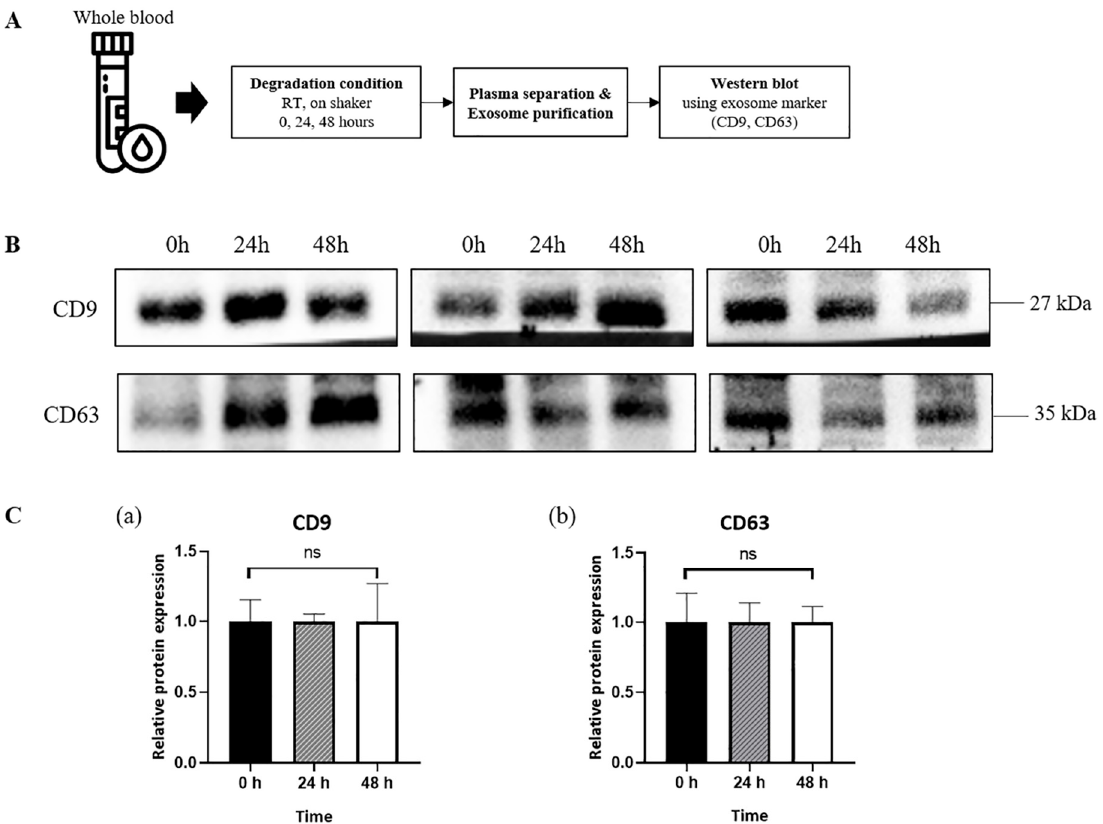
Figure 2. Sustained expression of the exosome surface proteins in the plasma exosomes of the healthy donors. ( A ) A description of the entire experimental process. ( B ) The western blot result of the healthy donors (n = 3) for the exosome surface proteins at 0, 24, and 48 h after isolation. ( C ) The relative protein expression of CD9 ( a ) and CD63 ( b ) were presented as the mean ± standard error of the mean (SEM) of the three experiments. Ns: not significant.